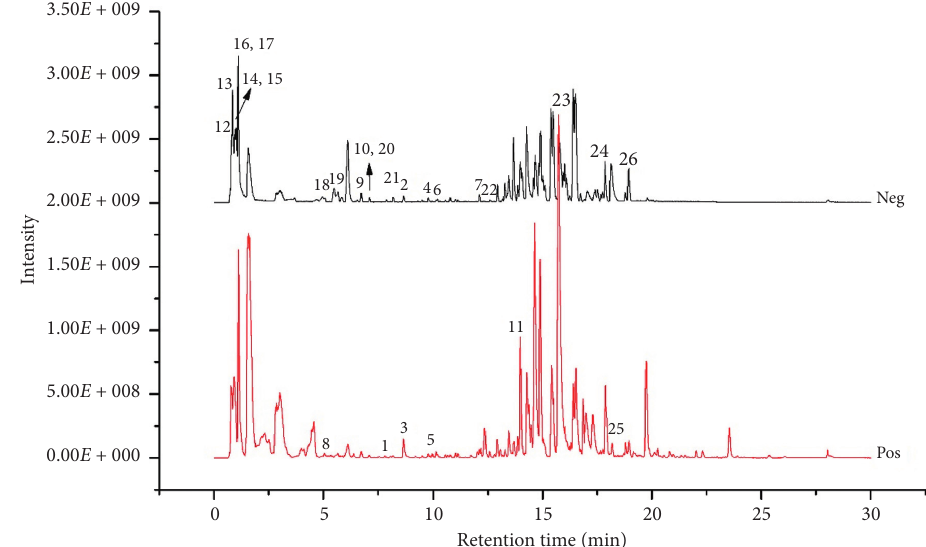
Figure 1: Total ion current chromatogram of F. velutipes in the positive ion mode (pos) and negative ion mode